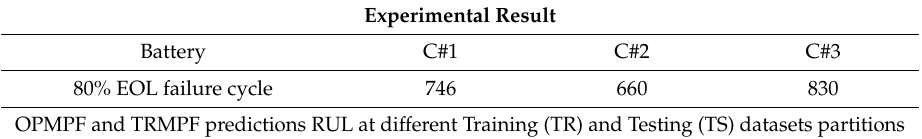
Table 4. End-of-life (EOL) failure cycle for the optimal and traditional particle filters for the batteries.